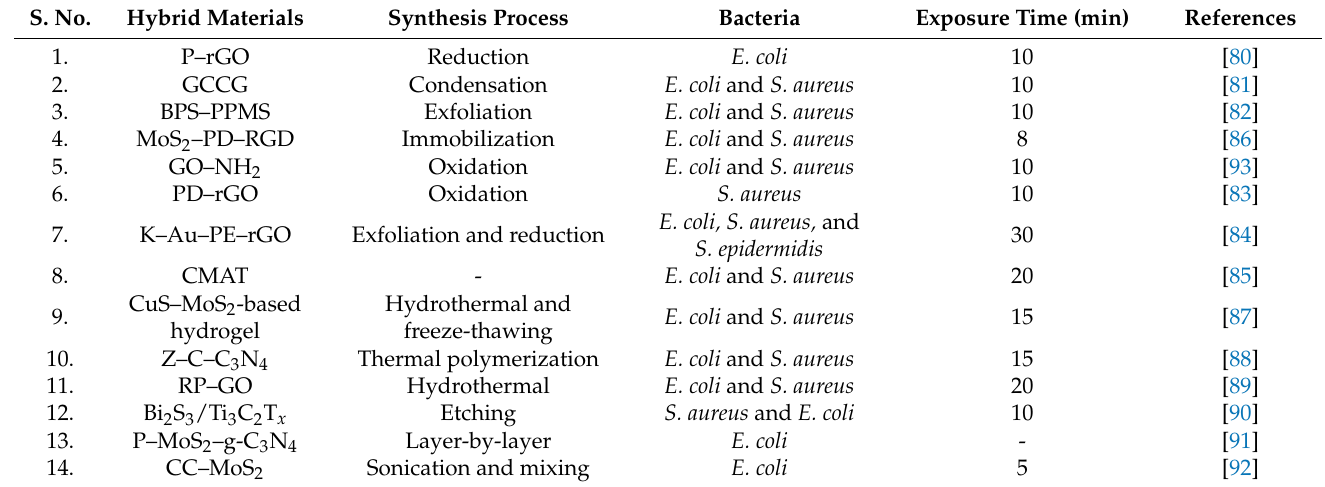
Table 3. 2D-NM-based hybrid materials and their photo-antibacterial